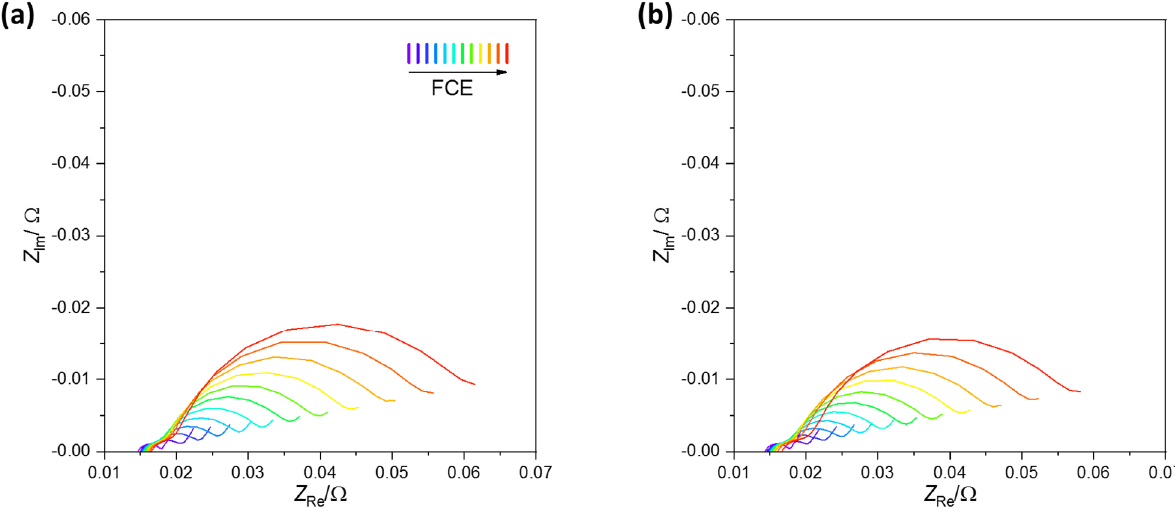
Figure 8. Development of the electrochemical impedance spectra measured at 100% SOC over 600 FCE ( a ), reference 2—2.5 A/2.5 A and ( b ) pulsed cha—50 Hz.